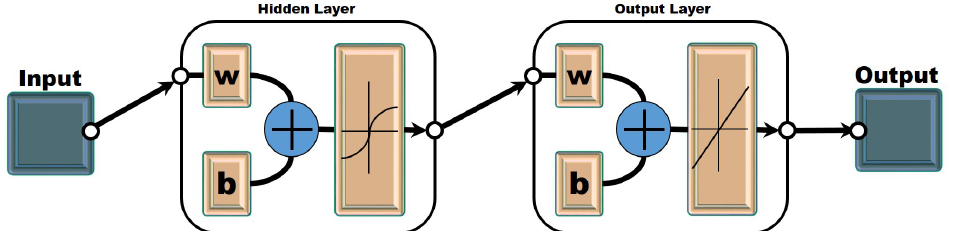
Figure 2. Architecture of Artificial Neural